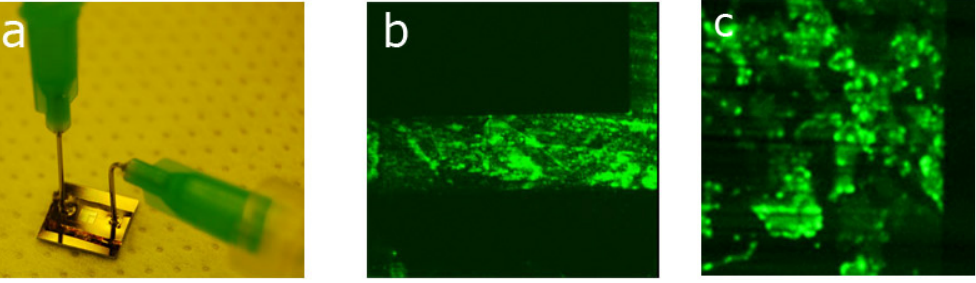
Figure 3. ( a ) CYTOP-PMMA-CYTOP waveguide chip bonded to a PDMS microfluidic circuit. A square-shaped sensing area is visible in the center of the chip; ( b ) False-color image of fluorescent beads in water solution passing through a 100 µm wide microfluidic channel above the sensing area. The penetration depth of the evanescent field into the solution is around 200 nm; ( c ) Live dSH2-GFP-expressing cells at the edge of the sensing area. The GFP attaches to focal adhesions in the